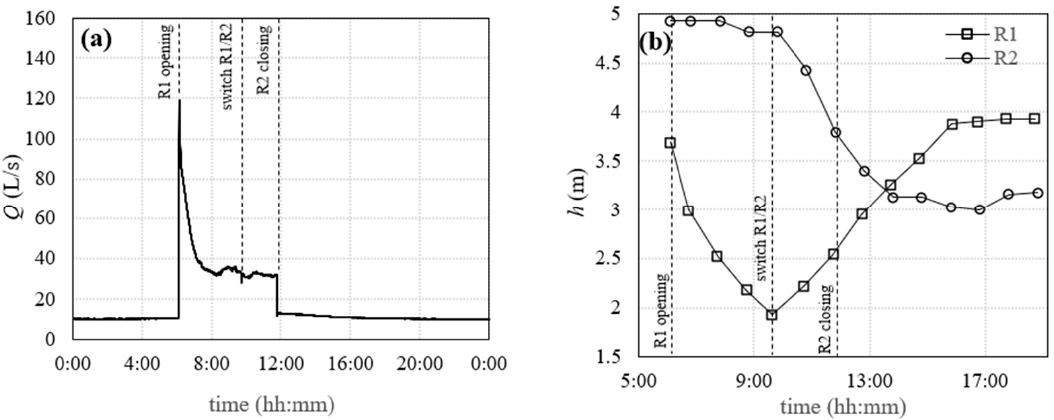
Figure 3. ( a ) Outflow discharge Q from the reservoirs, and ( b ) water level in R1 and R2. Experiment of Sunday, 16 June 2019.